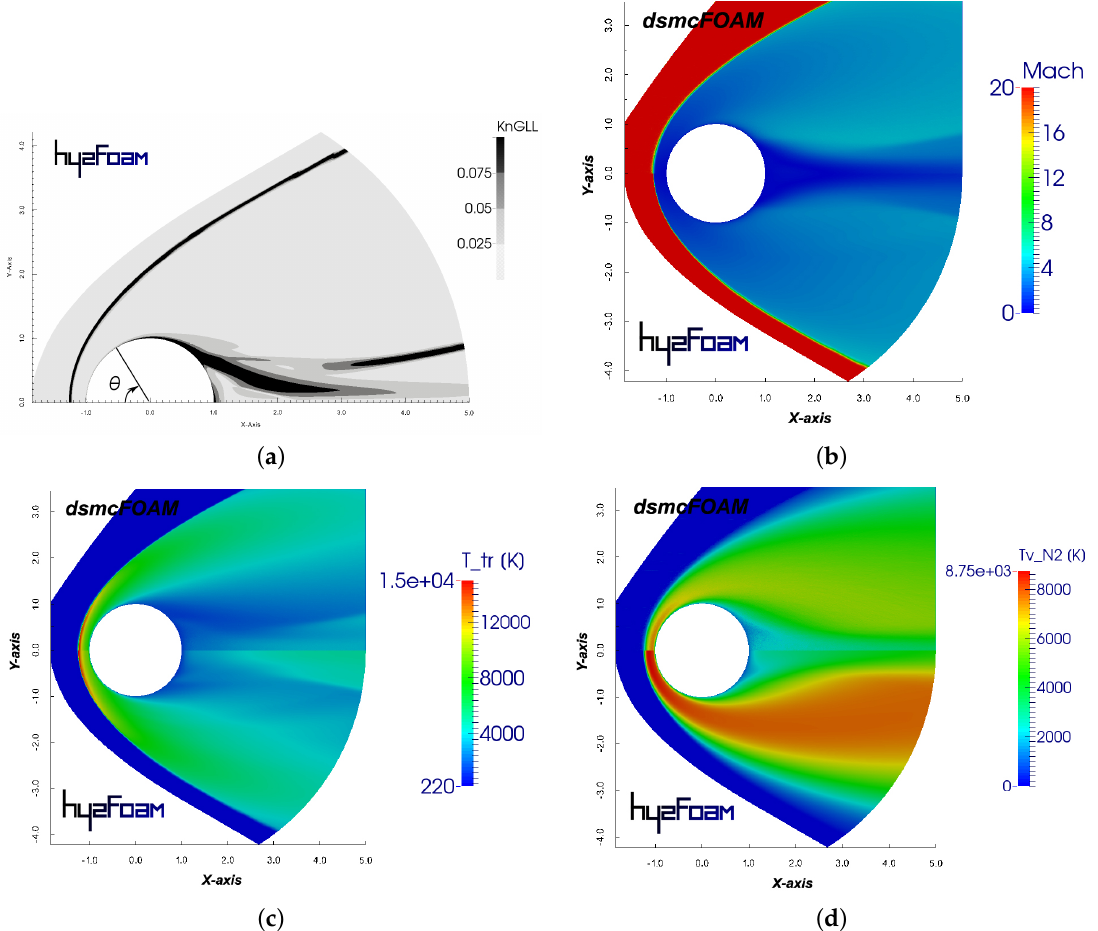
Figure 4. Computational fluid dynamics-direct simulation Monte Carlo (CFD-DSMC) flow-field comparisons for run number 2. In ( b – d ): the dsmcFoam solution is represented in the upper half and the hy2Foam solution in the lower half. ( a ) Local gradient-length Knudsen number; ( b ) Mach number; ( c ) trans-rotational temperature; and ( d ) vibrational